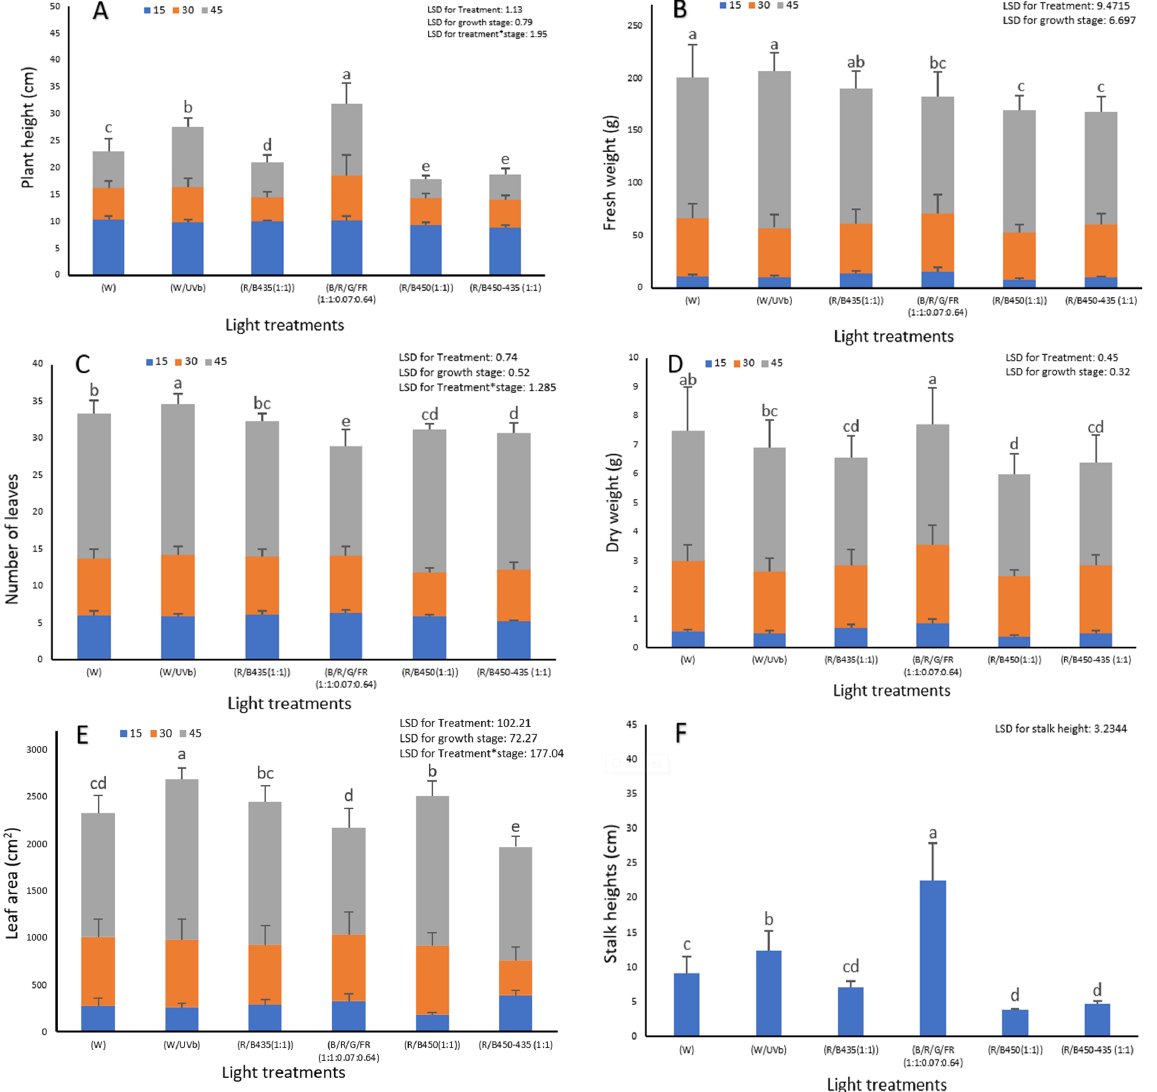
Figure 2. The impact of LED light spectrum on ( A ) plant height (cm); ( B ) plant fresh weight (g); ( C ) number of leaves; ( D ) plant fresh weight (g); ( E ) leaf area (cm 2 ) and ( F ) stalk height (cm) of green lettuce (Locarno variety) at three developmental stages, 15, 30 and 45 days from transplanting in the plant factory. Letters indicate significant differences ( p < 0.05) between treatments within each ex- periment (* refers to the interaction between treatments).